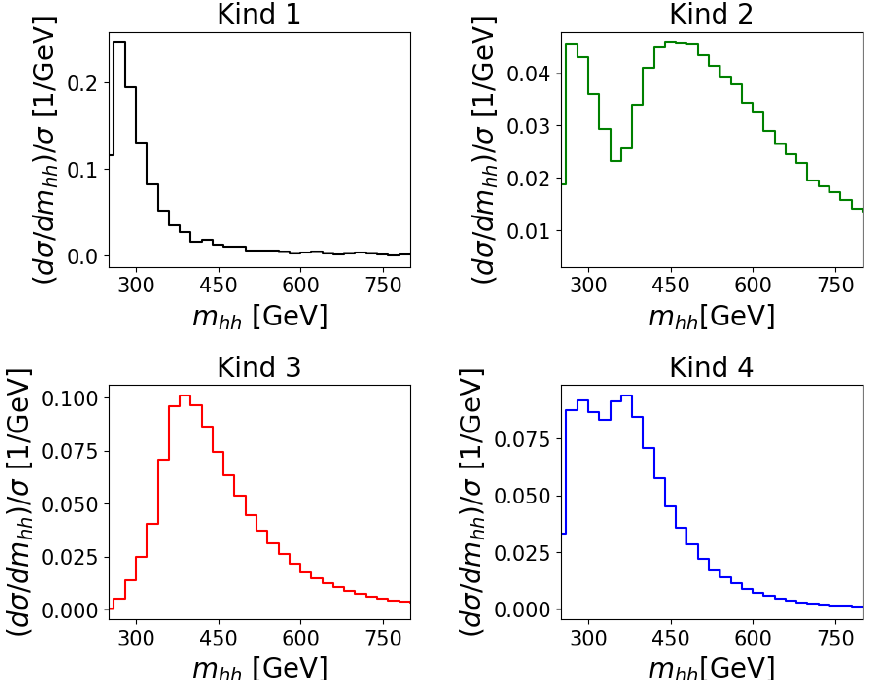
Figure 1 . The four kinds of shapes de(cid:12)ned in our analyzer to classify the m hh distributions. The colours correspond to the colours shown in (cid:12)gures 2 to